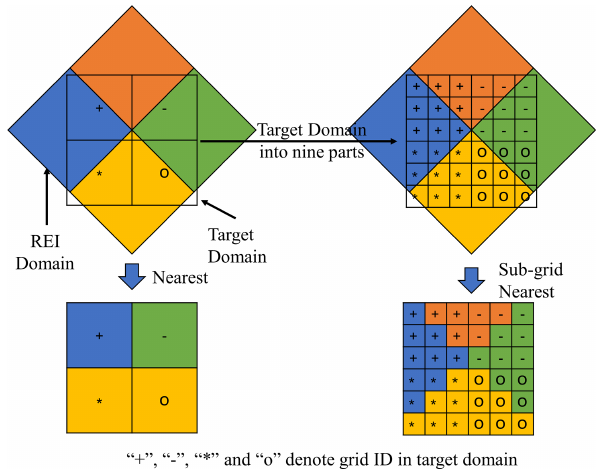
Figure 3. Concept of the sub-grid nearest